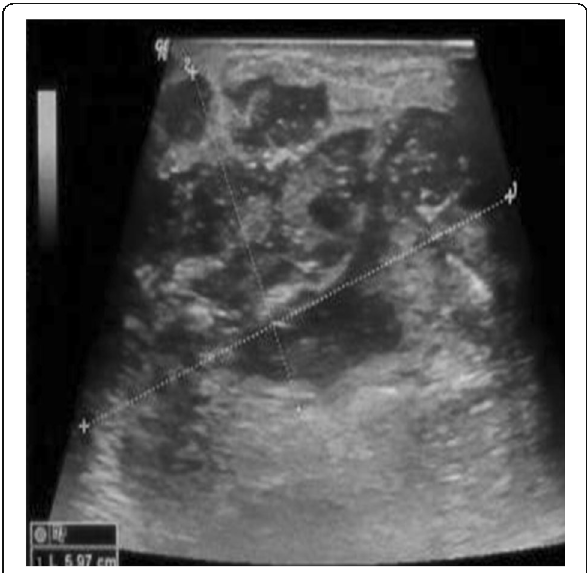
Fig. 1 Case with B-B fistula on gray scale image shows an infected hematomas forming subcutaneous